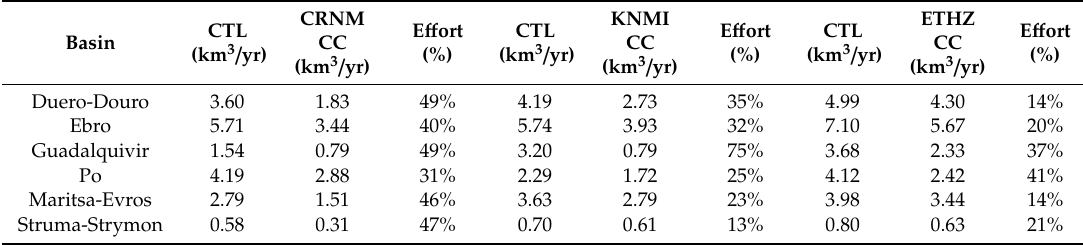
Table 3. Water availability for irrigation and adaptation effort under the A1B scenario according to the three RMCs in A1B emission scenario.